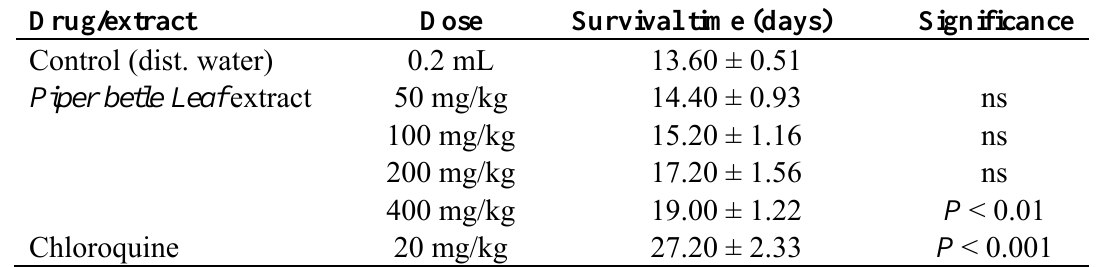
Table 3. Mean survival period of mice treated with Piper betle in established malaria infection. Drug/extract